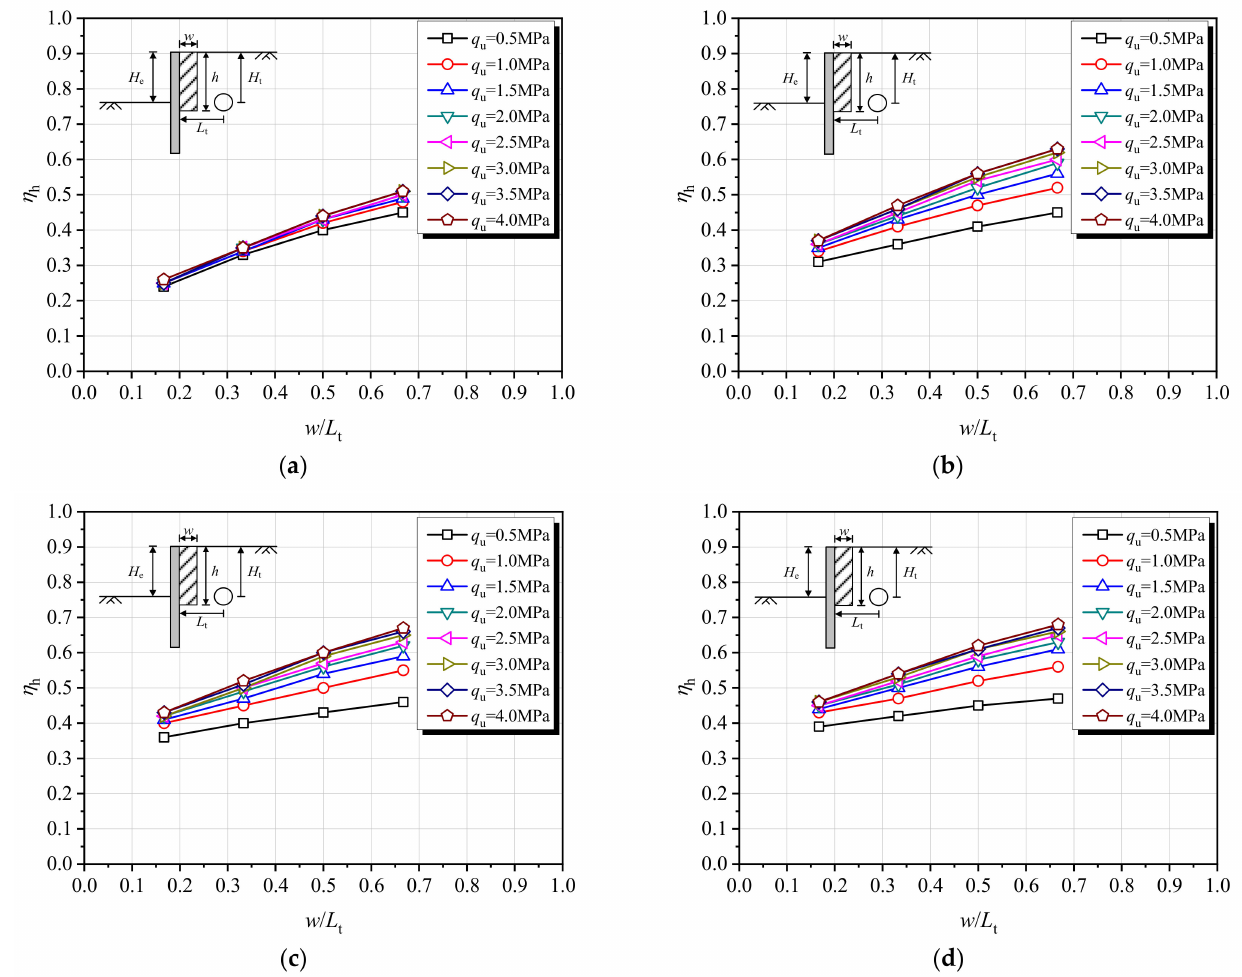
Figure 13. Evolution curves of η h with w : ( a ) h = 1.5 H t ; ( b ) h = 2.0 H t ; ( c ) h = 2.5 H t ; ( d ) h = 3.0 H t